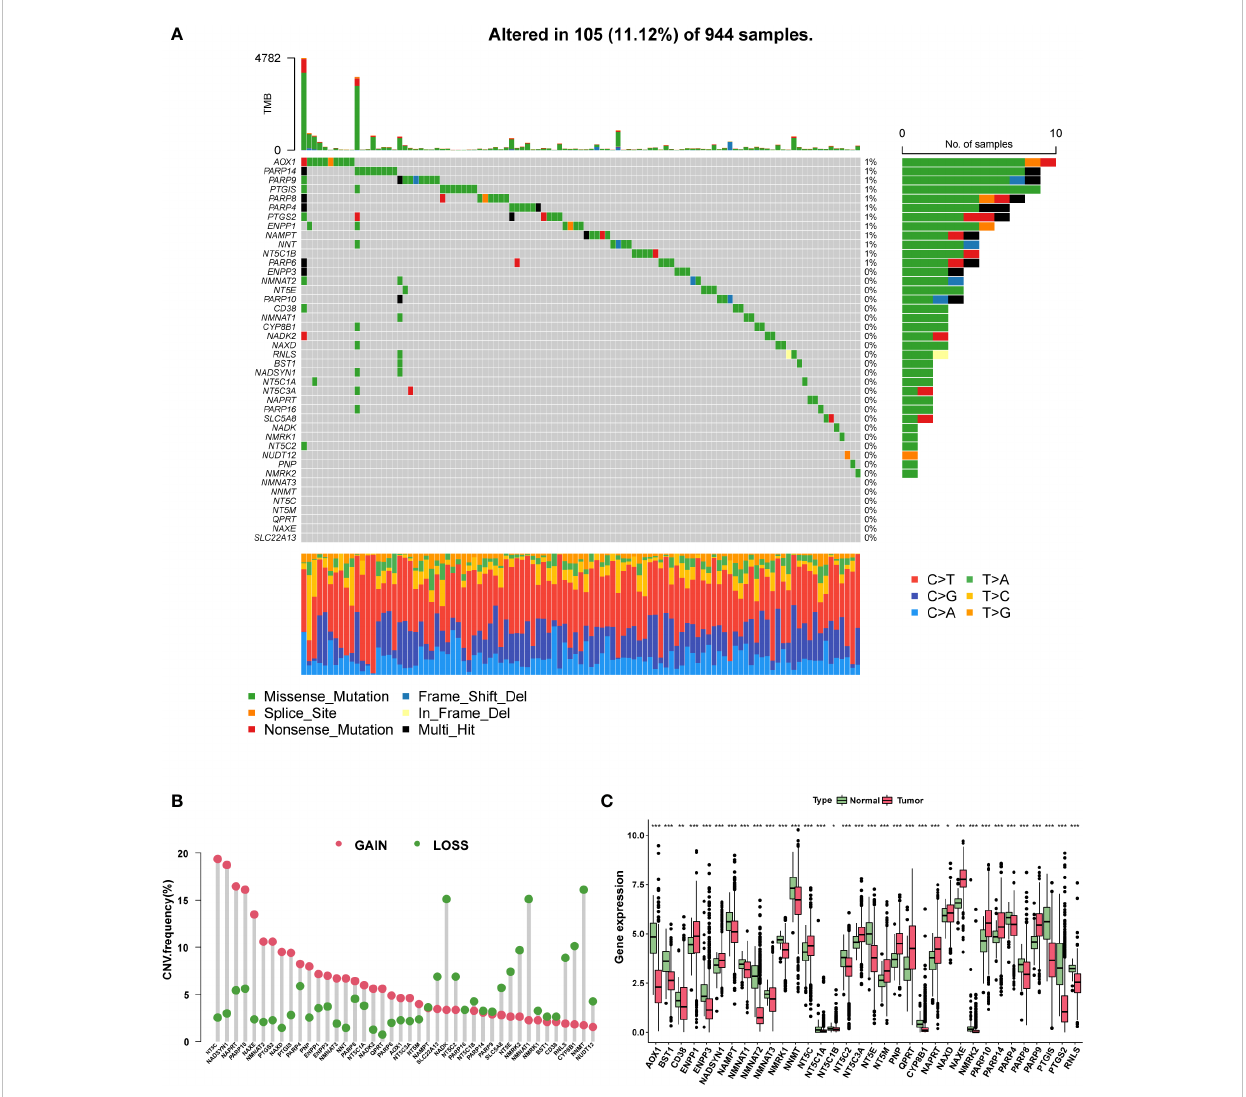
FIGURE 2 The genomic and transcriptomic landscape of NMRGs. (A) The mutation landscape of NMRGs in the TCGA database. (B) The CNV frequency of NMRGs. (C) The differential expression of NMRGs in BC between tumor and adjacent normal tissues (* p<0.05, ** p<0.01, ***